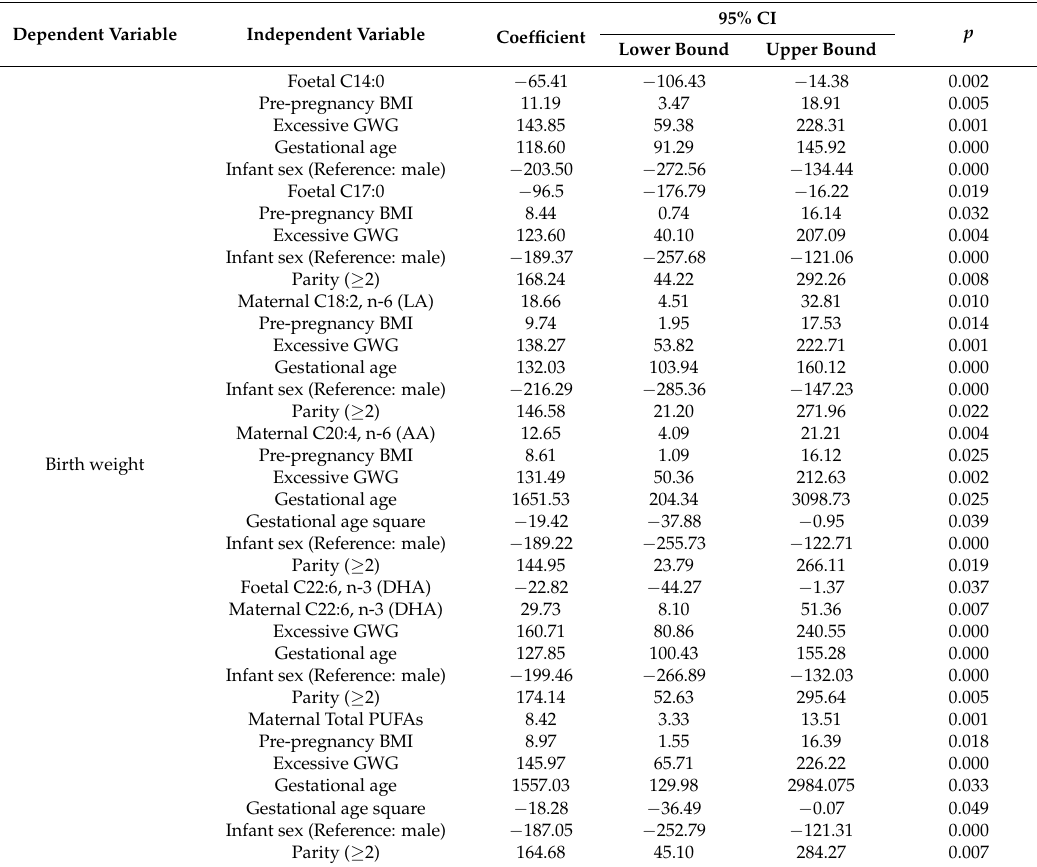
Table 2. Adjusted association between maternal/infant lipid profile and infant birth weight. Dependent